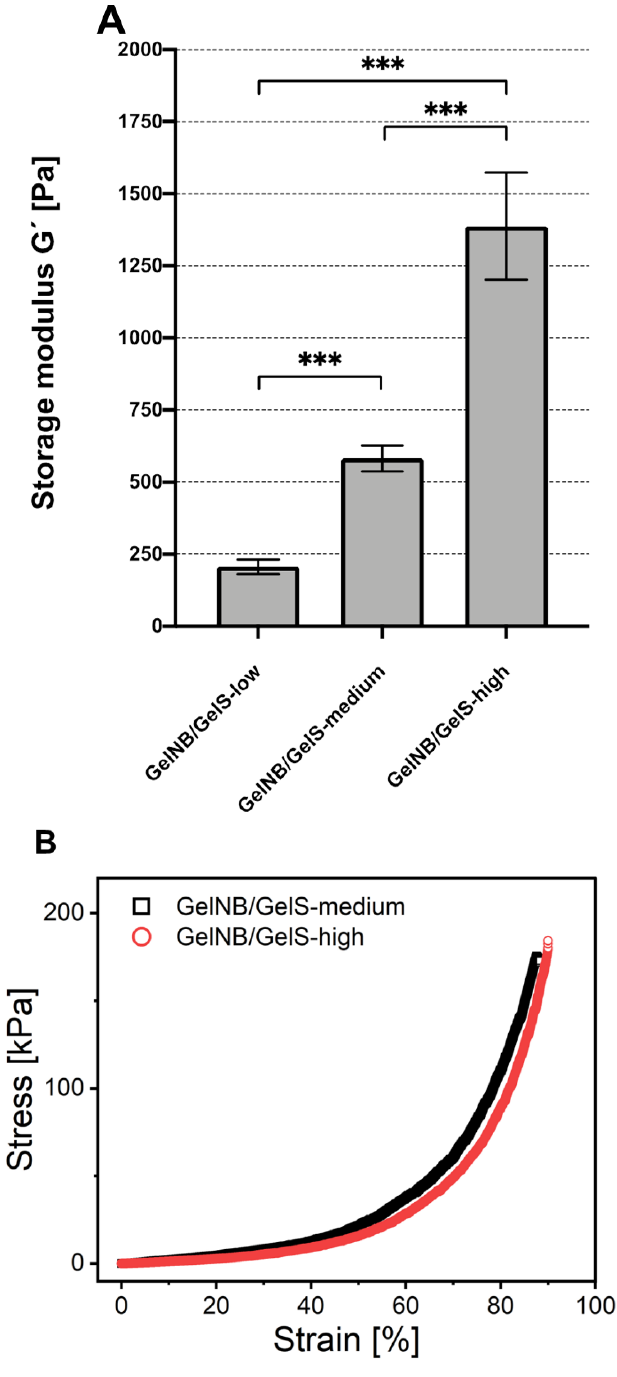
Figure 1. Determination of the storage moduli and elastic moduli of GelNB/GelS-low, GelNB/GelS- medium and GelNB/GelS-high hydrogels. The tests were performed for crosslinked hydrogels at RT. ( A ) For the determination of the storage modulus, all dynamic moduli were measured at a 1 Hz oscillation frequency in the plateau regime. Means ± SD are shown for at least 153 measuring points of one hydrogel per experimental group. G ′ : storage modulus (Pa). Asterisks indicate statistically significant differences between the groups. (*** p < 0.0005). ( B ) Representative compression stress– strain curves of GelNB/GelS-medium and GelNG/GelS-high for the determination of the elastic modulus. Samples (n = 3) were compressed at a speed of 10% min − 1 . The elastic modulus was calculated from the slopes of the compression stress–strain curves in the 10–20% strain